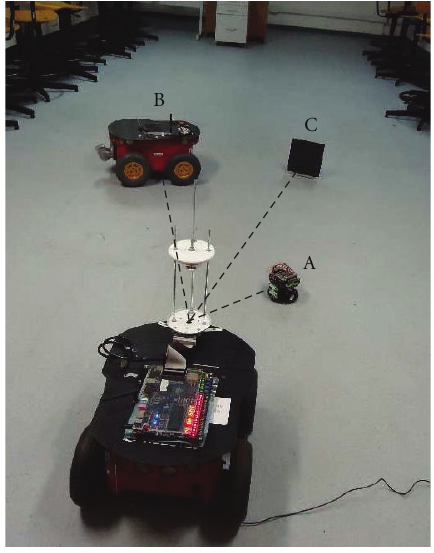
Figure 16: Objects used for testing the overall